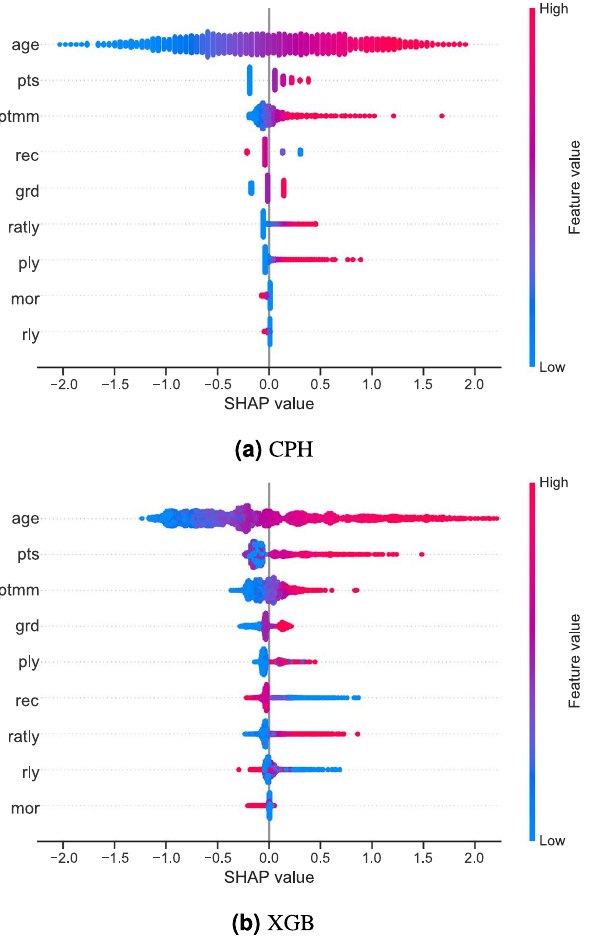
Figure 2. Summary plots for SHAP values. For each feature, one point corresponds to a single patient. A point’s position along the x axis (i.e., the actual SHAP value) represents the impact that feature had on the model’s output for that specific patient. Mathematically, this corresponds to the (logarithm of the) mortality risk relative across patients (i.e., a patient with a higher SHAP value has a higher mortality risk relative to a patient with a lower SHAP value). Features are arranged along the y axis based on their importance, which is given by the mean of their absolute Shapley values. The higher the feature is positioned in the plot, the more important it is for the